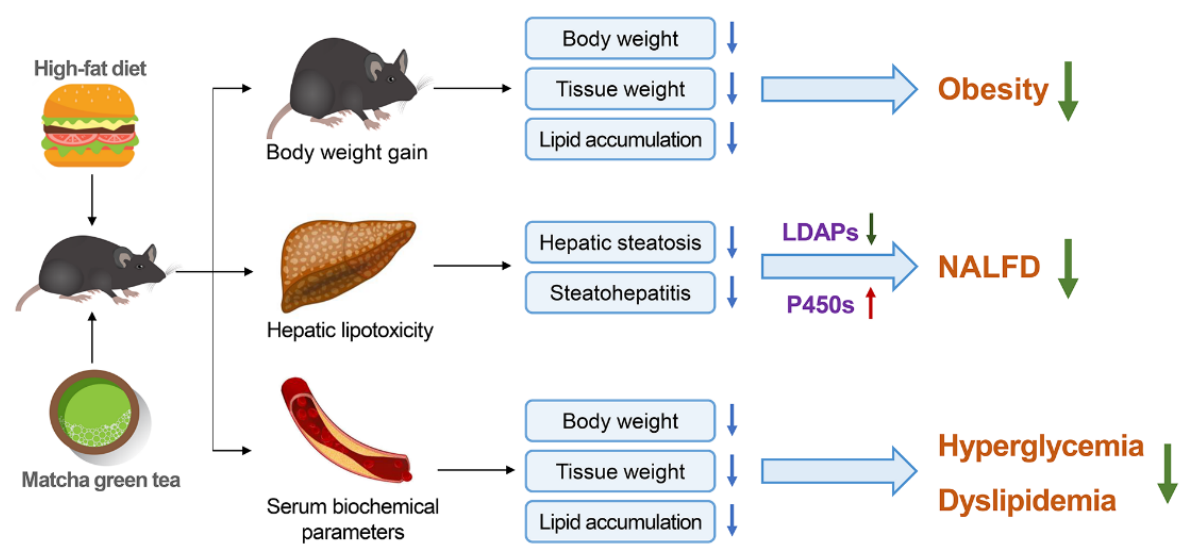
Figure 5. Schematic diagram showing the possible mechanisms of matcha green tea preventing high-fat diet-induced obesity and hepatic lipotoxicity.